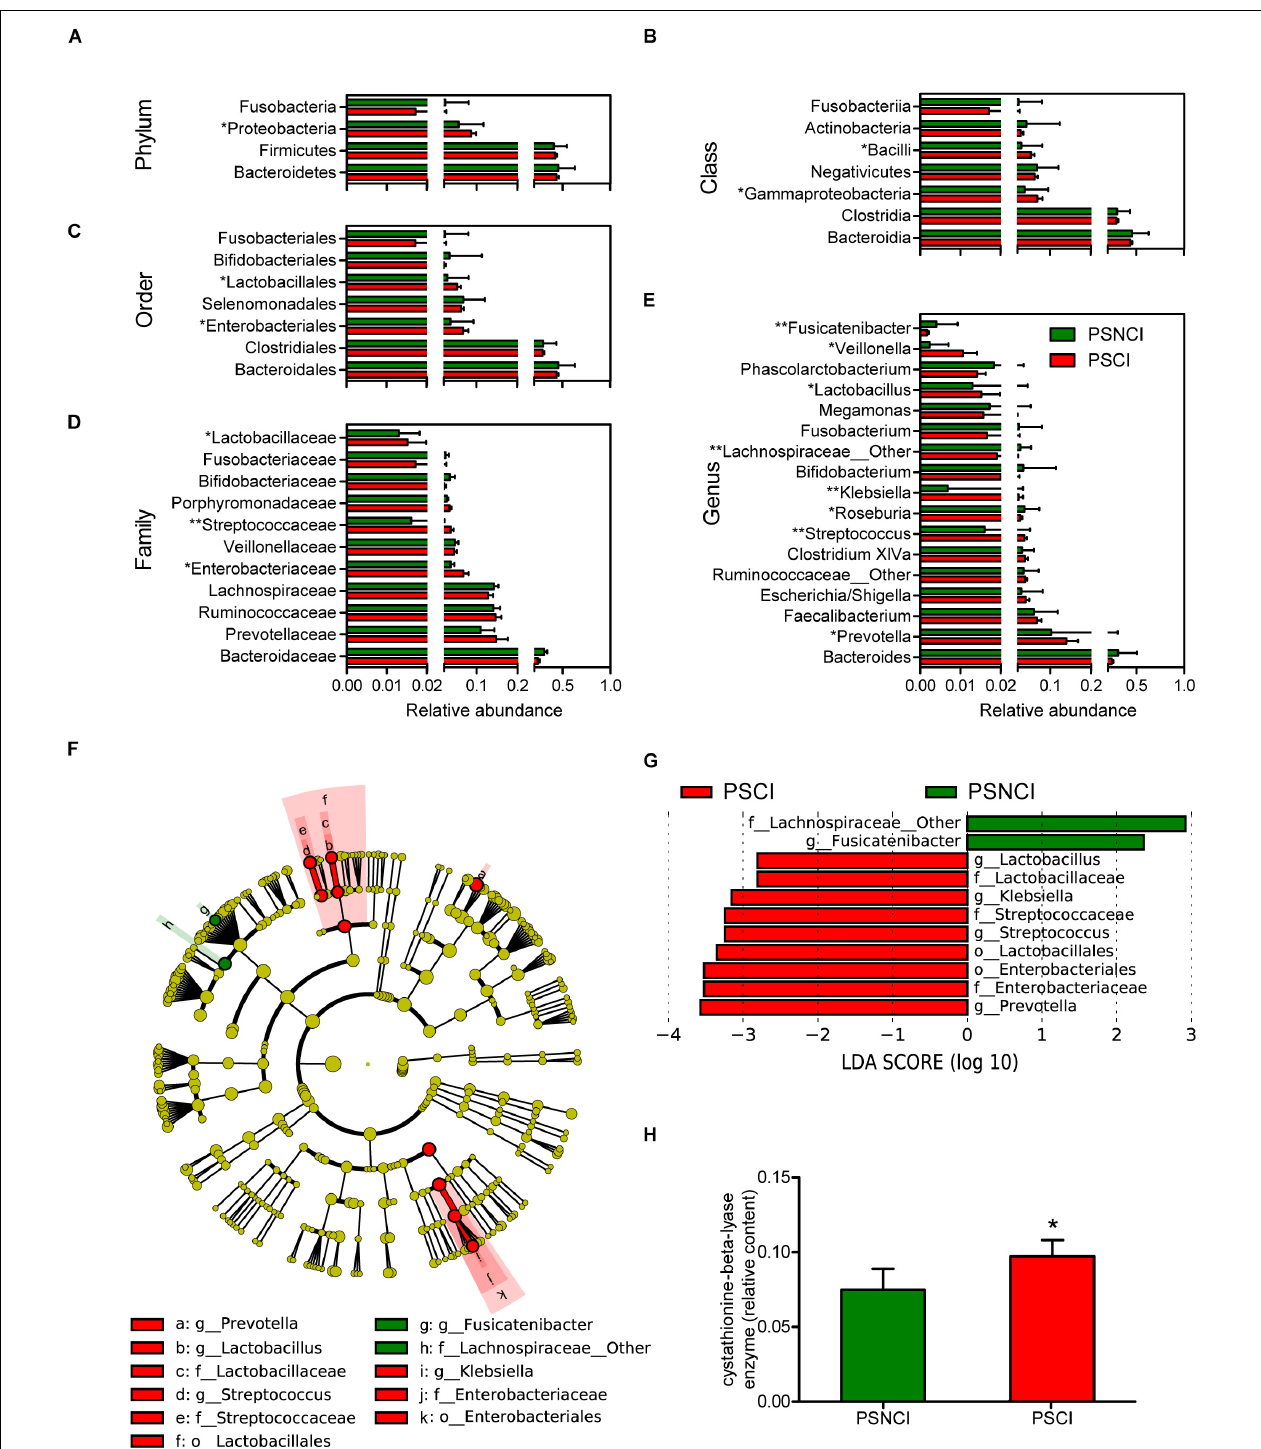
FIGURE 2 | Comparison of the representative taxonomic abundance between post-stroke cognitive impairment (PSCI) and post-stroke non-cognitive impairment (PSNCI) groups. (A) Mann-Whitney U -test indicated the significant differences in phylum between the two groups and also in their corresponding class (B) , order (C) , family (D) , and genus (E) . (F) A cladogram of different taxonomic composition between PSCI patients and PSNCI patients. (G) linear discriminant analysis scores showed significant bacterial differences between PSCI patients and PSNCI patients. (H) Compare the functional Kyoto Encyclopedia of Genes and Genomes orthology of gut microbiota in PSCI and PSNCI groups. Mann-Whitney U -test indicated the significant differences between the two groups. o, order; f, family; g, genus. * P < 0.05, ** P < 0.01.